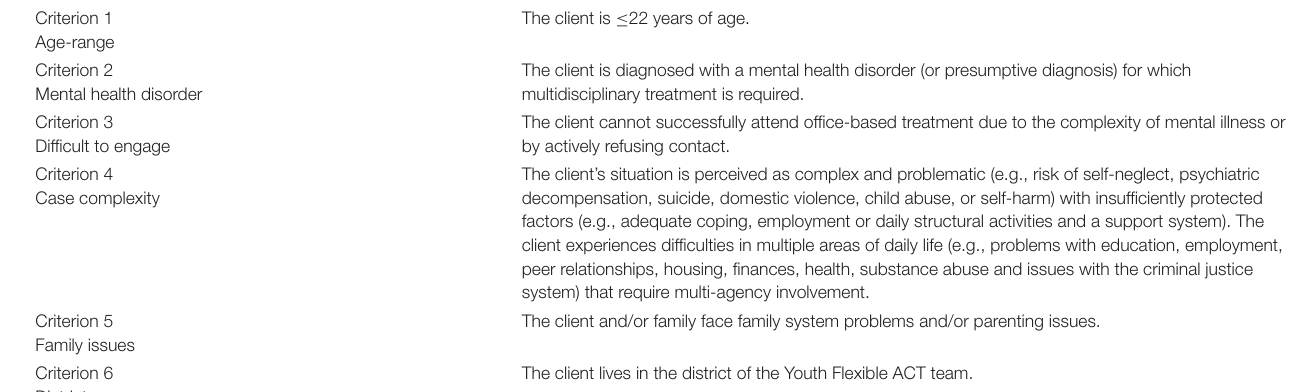
The client is ≤ 22 years of